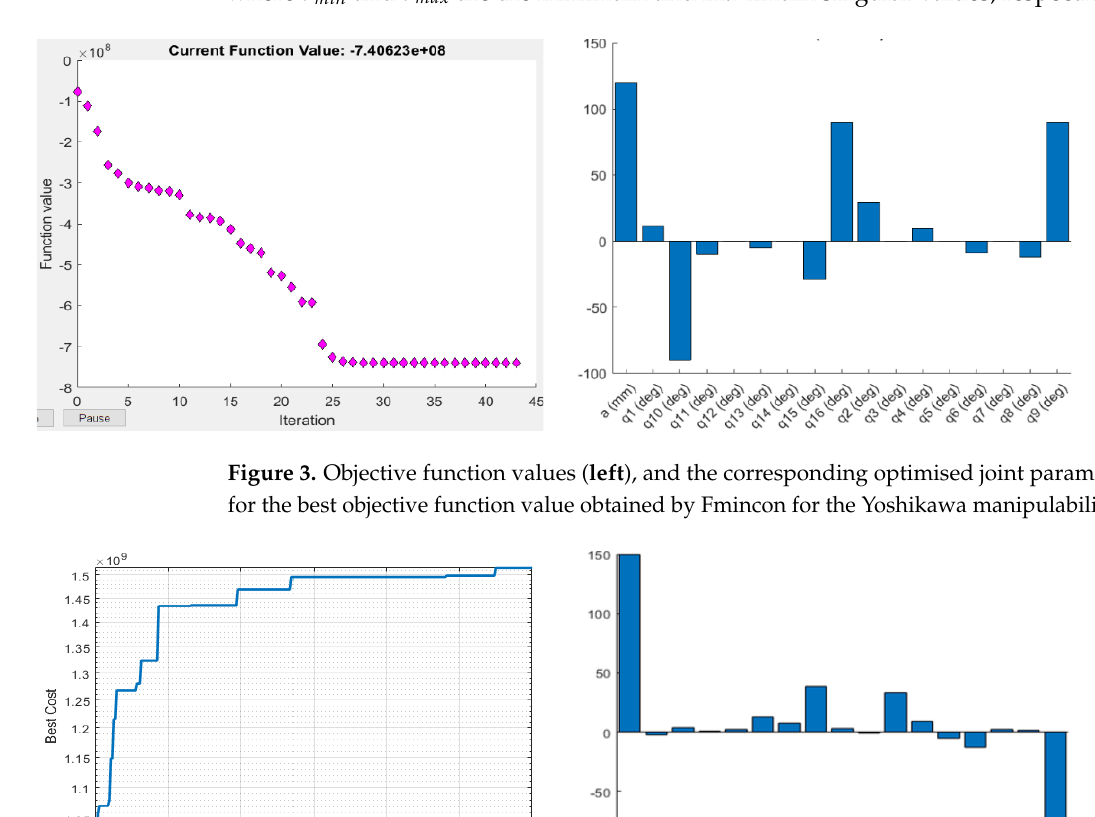
Figure 3. Objective function values ( left ), and the corresponding optimised joint parameters ( right ) for the best objective function value obtained by Fmincon for the Yoshikawa manipulability meas- ure.